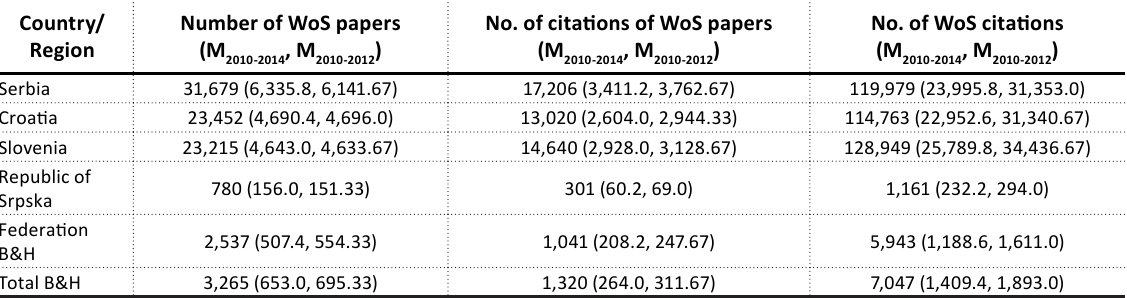
Table 3. Total number of WoS papers, quotations and citations from 2010 to